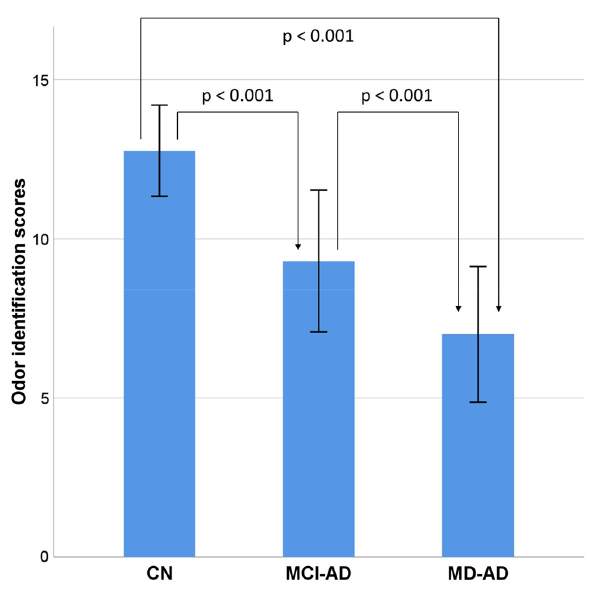
Figure 1. Odor identification scores in three groups of participants. Bars represent mean values, and error bars represent standard